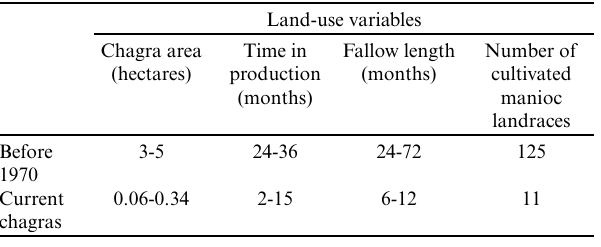
Table 3 . Changes in land-use patterns as described by